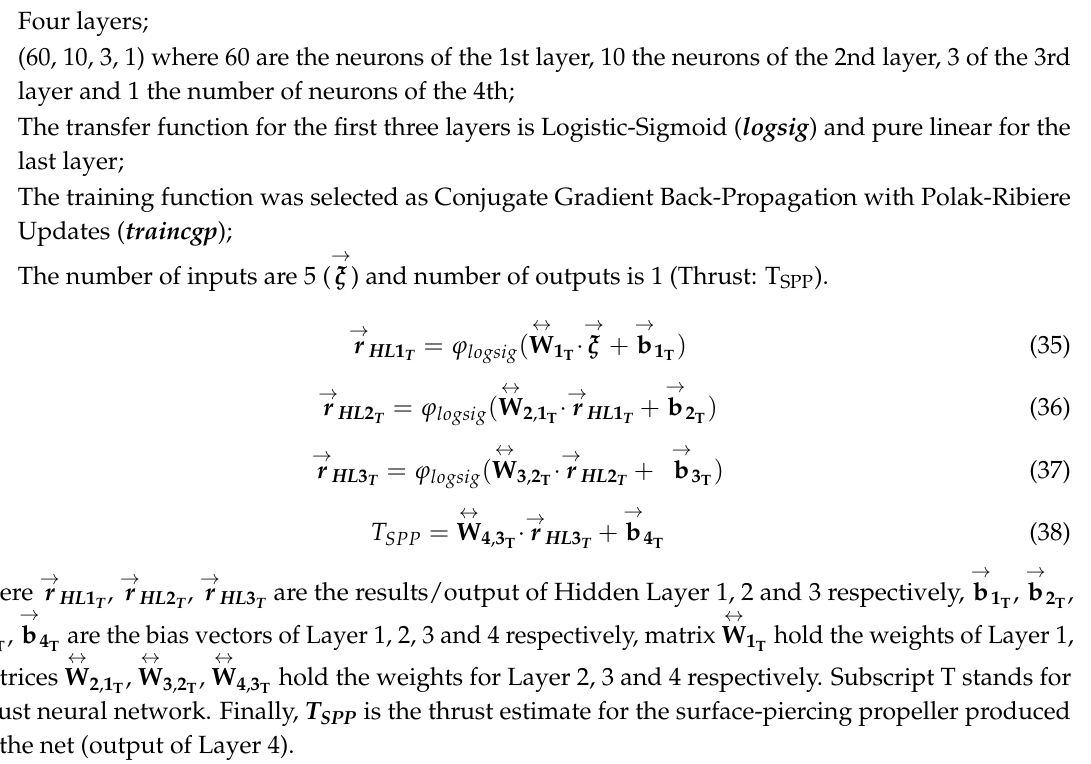
Figure 10. Thrust neural network topology.